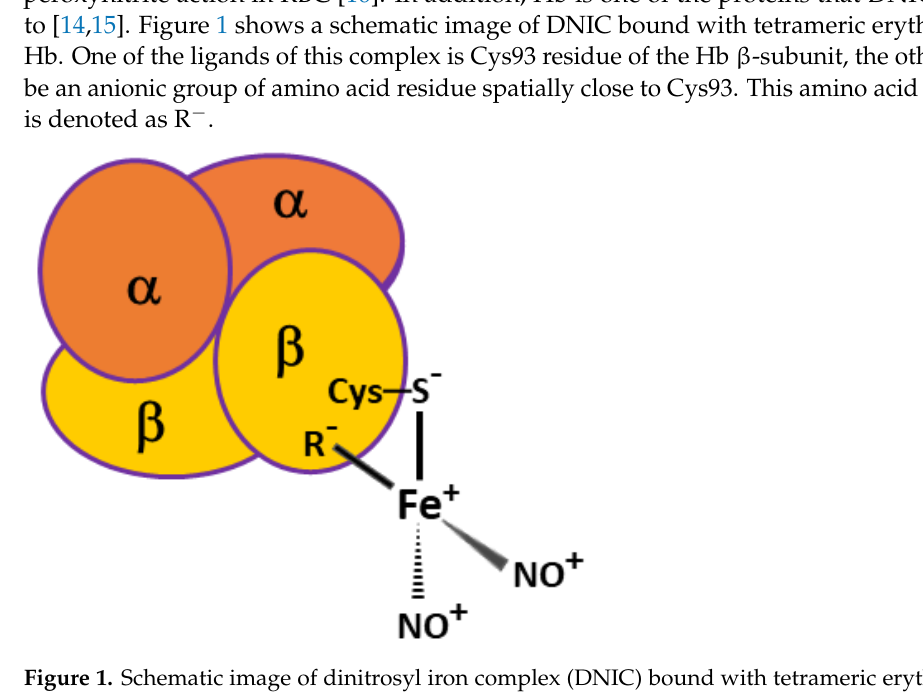
Figure 1. Schematic image of dinitrosyl iron complex (DNIC) bound with tetrameric erythrocytic hemoglobin (Hb-DNIC).